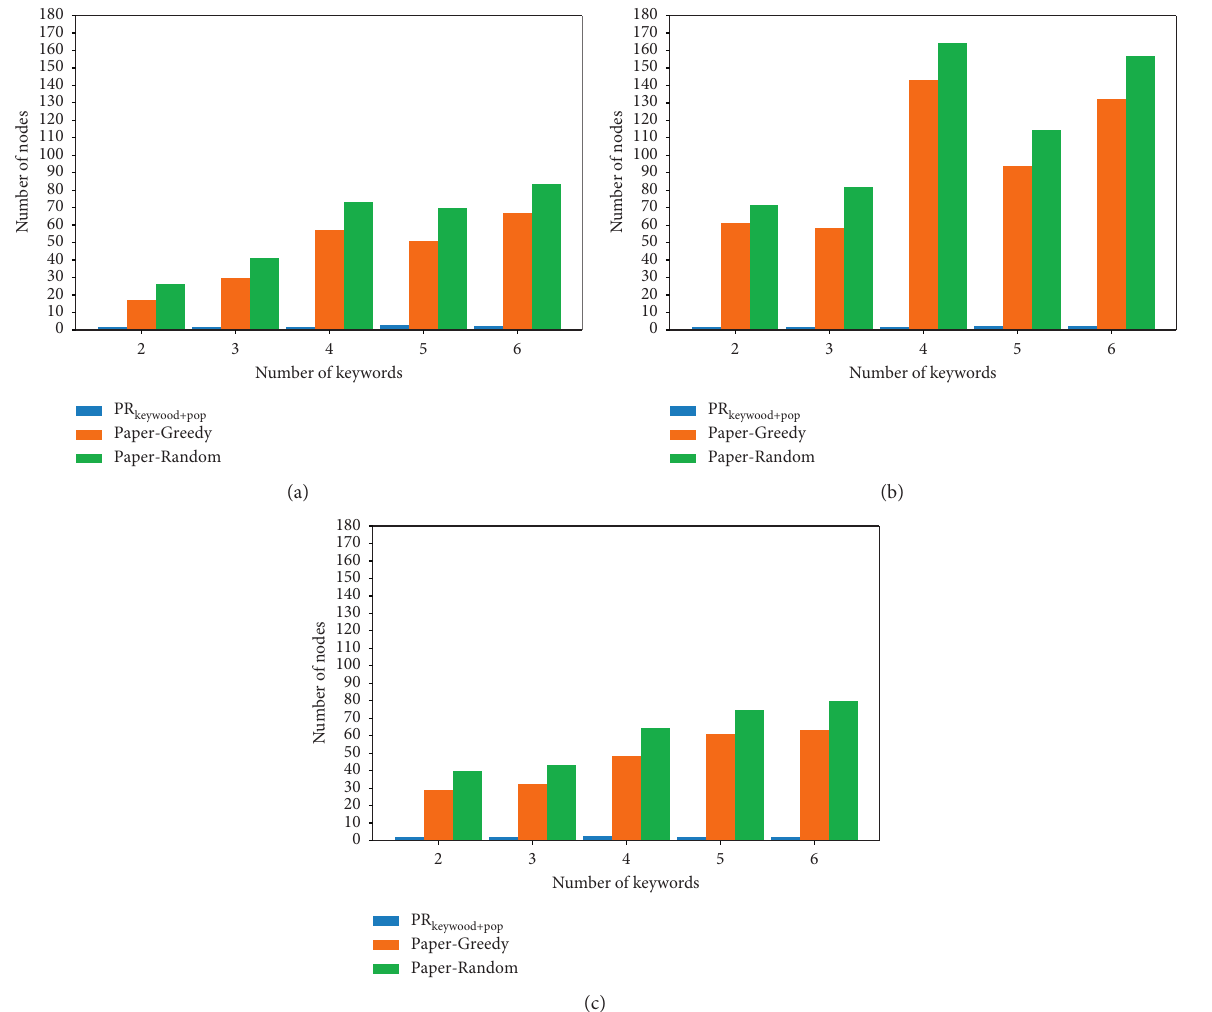
Figure 8: The number of recommended nodes of different approaches: (a) set A, (b) set B, and (c) set